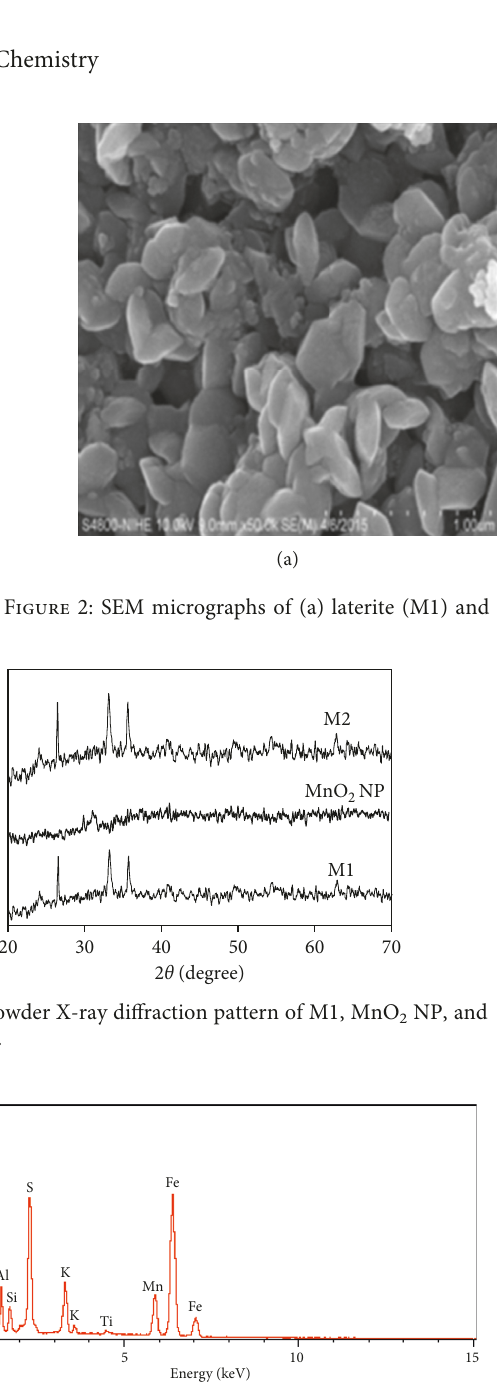
Figure 4: Energy-dispersive X-ray (EDX) spectra of the mixed laterite after MnO 2 NP (M2) coating.